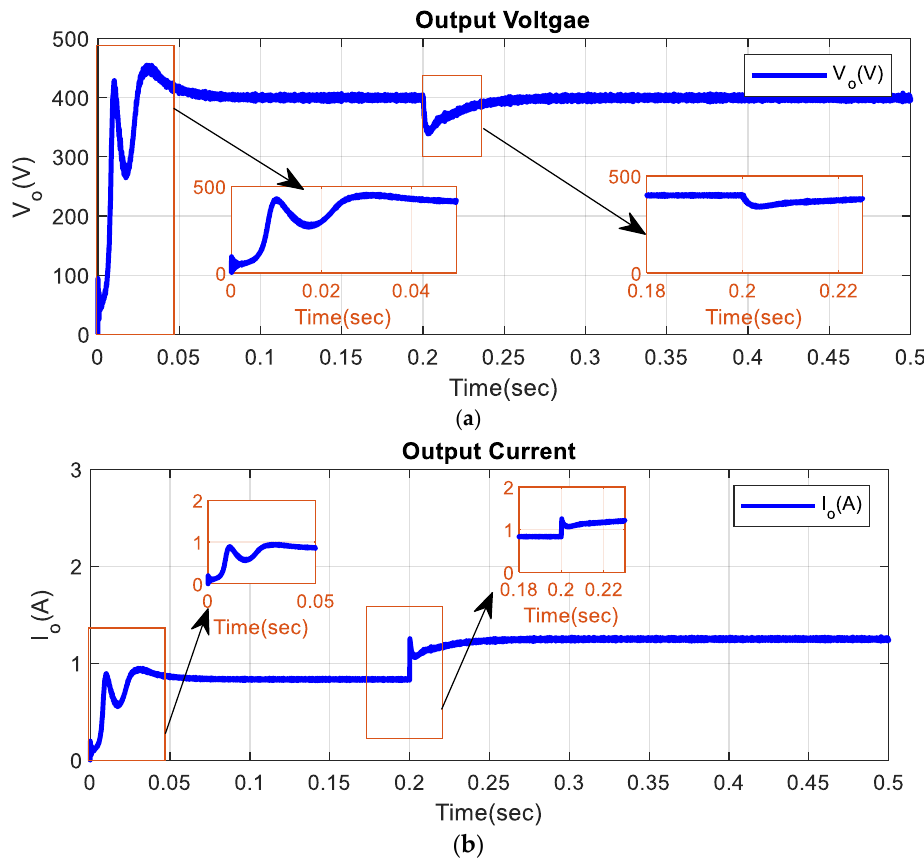
Figure 16. Load parameters during load change from 500 W to 1000 W.